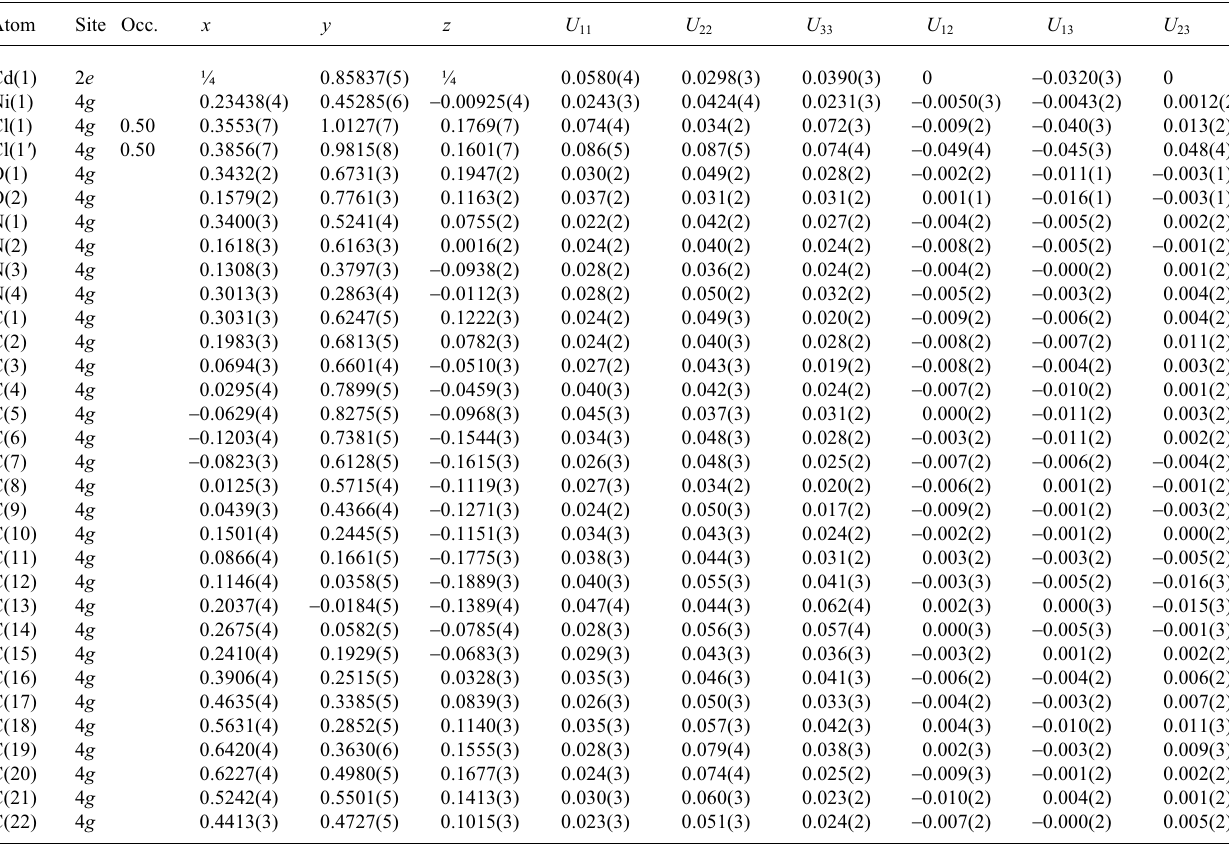
Table 3. Atomic coordinates and displacement parameters (in Å 2